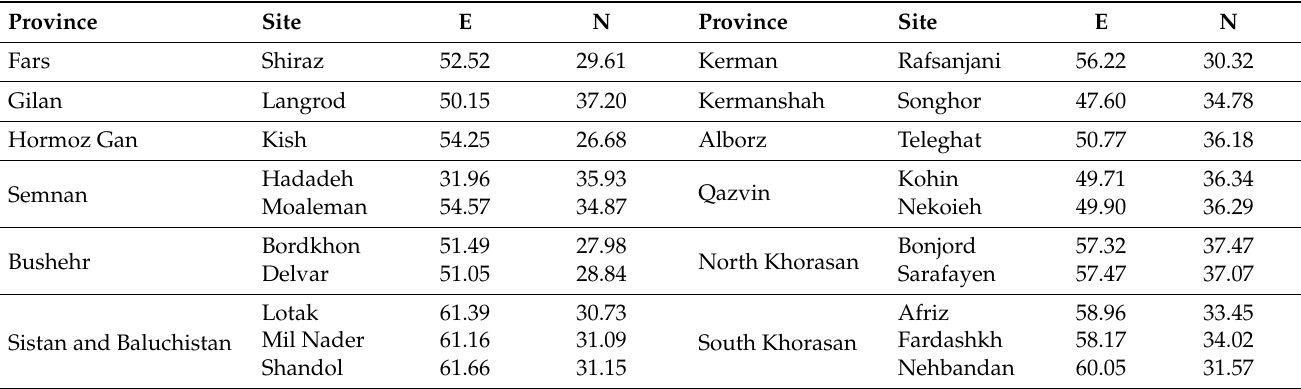
Table 1. Location of the investigated